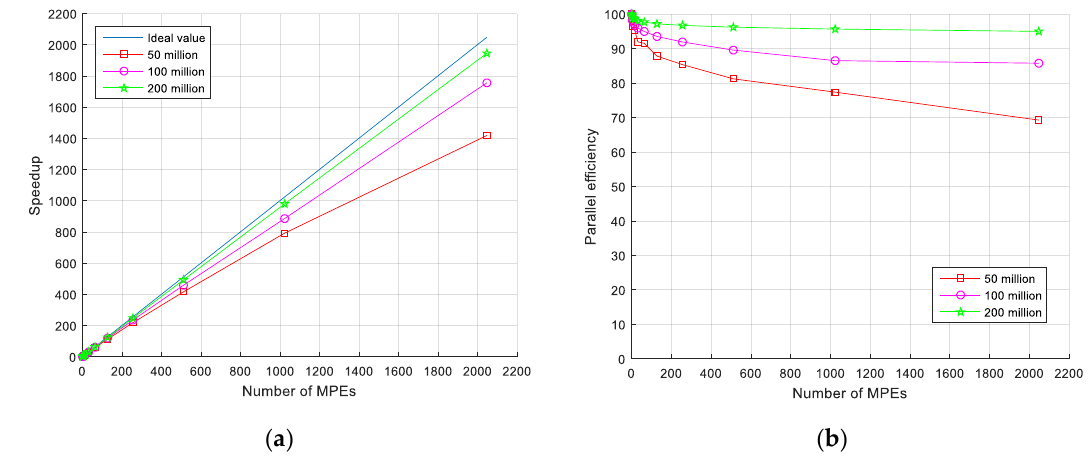
Figure 8. For only management processing elements (MPEs) at three problem sizes: ( a ) Acceleration ratio; ( b ) Parallel efficiency.